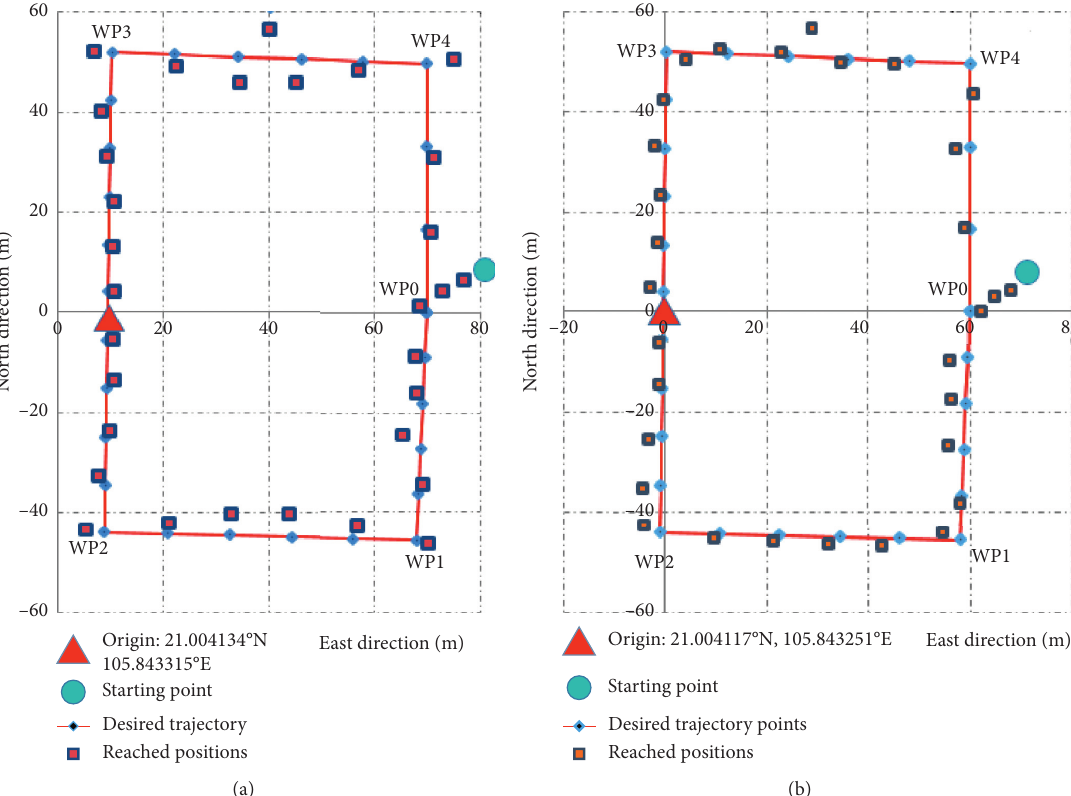
Figure 10: M-AUV reaches and follows the rectangle-shaped planar trajectory (a) with the EKF algorithm and (b) with the UKF algorithm.